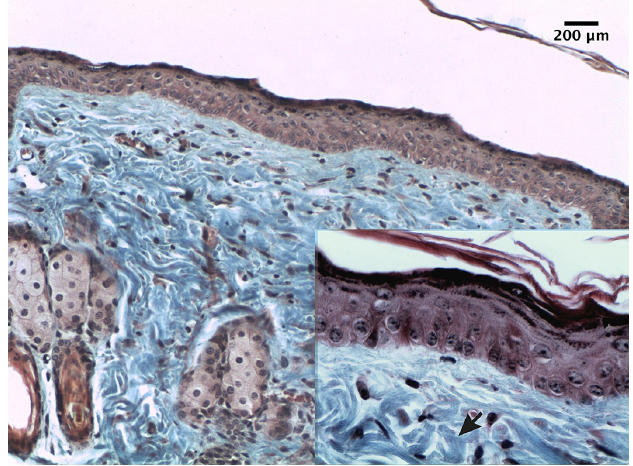
FIGURE 4 - Photomicrograph of male mouse skin from group 6 (CTRL) stained with Masson’s trichrome to observe collagen fibers (x100, detail